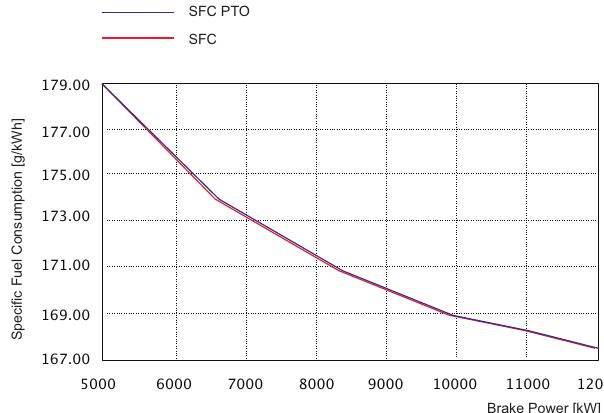
Figure 8. Specific Fuel oil Consumption (SFC) difference at PTO and without shaft